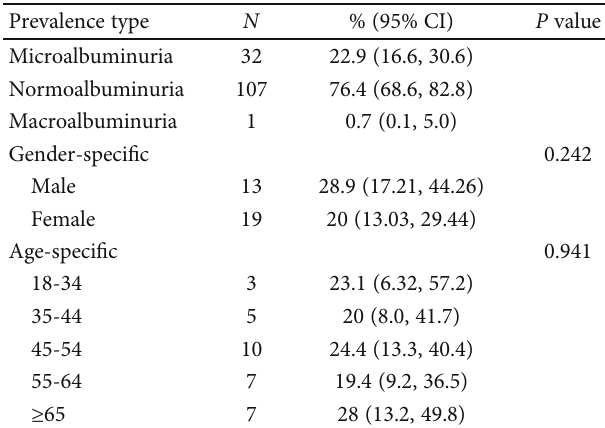
Table 3: Prevalence of microalbuminuria and its distribution according to age group and